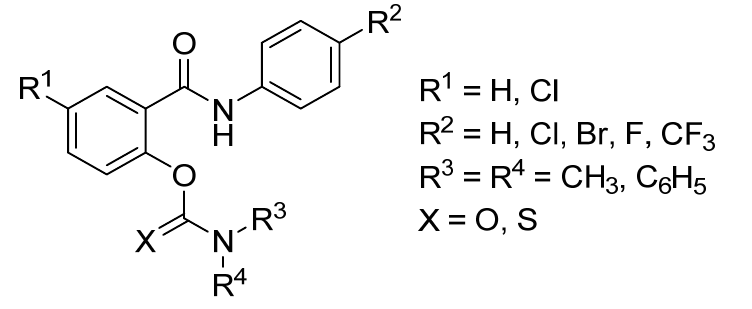
Figure 2. Salicylanilide (thio)carbamates 1a – 5d